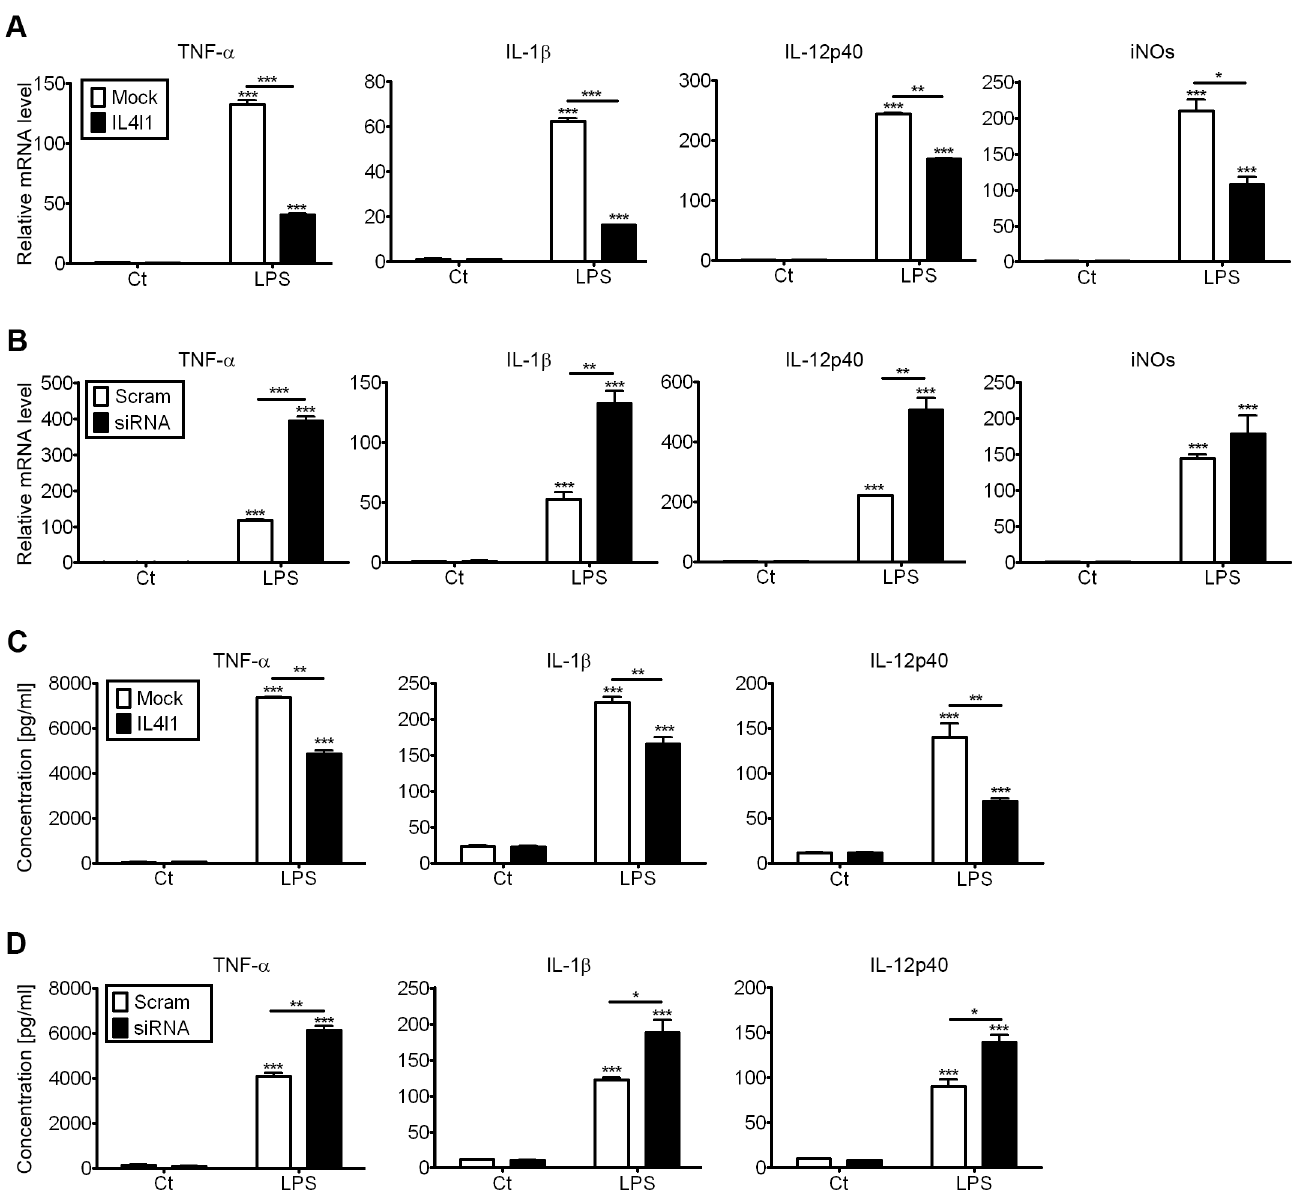
Fig 4. IL4I1 limits acquisition of M1 phenotypes. BMDMs were infected with IL4I1-recombinant or control retrovirus, then were either untreated or treated with LPS (100 ng/mL) for 24 h. Levels of TNF- α , IL-1 β , IL-12p40, and iNOS mRNA transcript expression were assayed by q-PCR (A) and those of TNF- α , IL- 1 β , and IL-12p40 protein expression were assayed by ELISA (C). BMDMs were transfected with siRNA against IL4I1 or scrambled siRNA for 24 h, then were untreated or treated with LPS (100 ng/mL) for 24 h. Levels of TNF- α , IL-1 β , IL-12p40, and iNOS gene expression were assayed by q-PCR (B) and those of TNF- α , IL-1 β , and IL-12p40 protein expression were assayed by ELISA (D). Representative data are presented as means ± S.D. of five independent experiments. Significance was calculated by one-way ANOVA with multiple comparison post test (Bonferroni). Asterisks indicate statistically significant differences, either compared to control, or between two conditions that are linked by a bar; * p < 0.05, ** p < 0.01, *** p <